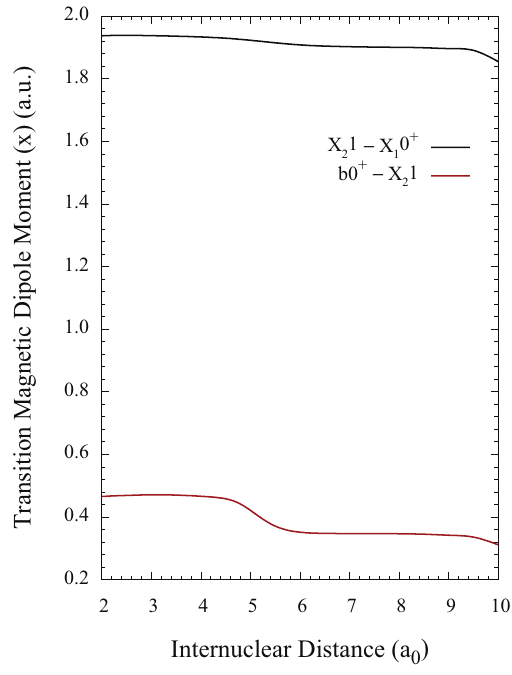
Figure 3. Magnetic dipole transition moments of TeH +